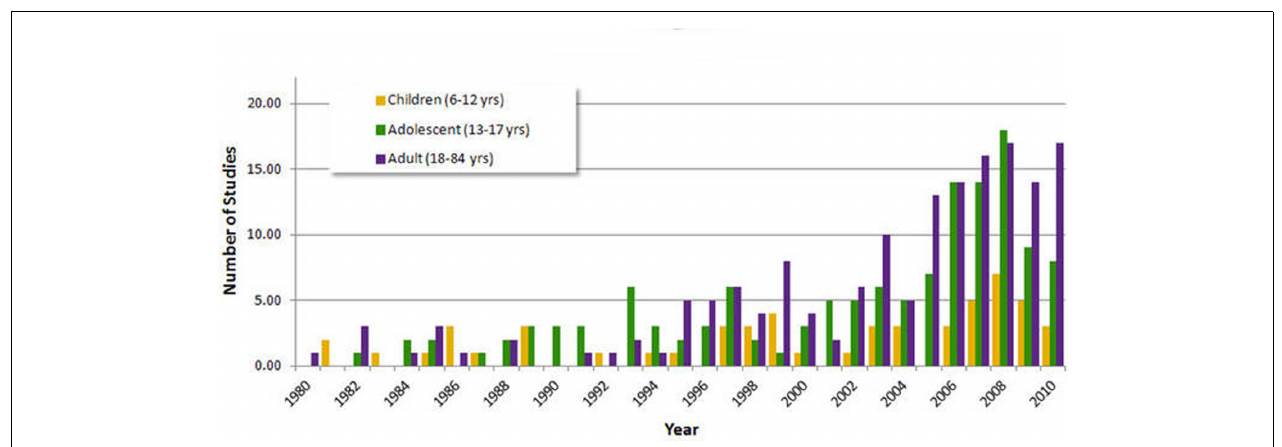
FIGURE 4 | Participant ages by year. There are more and more studies of adolescents and adults being published, while the number of studies of children remains relatively stable. Adults are often studied retrospectively, which may explain the results shown in Figure 3